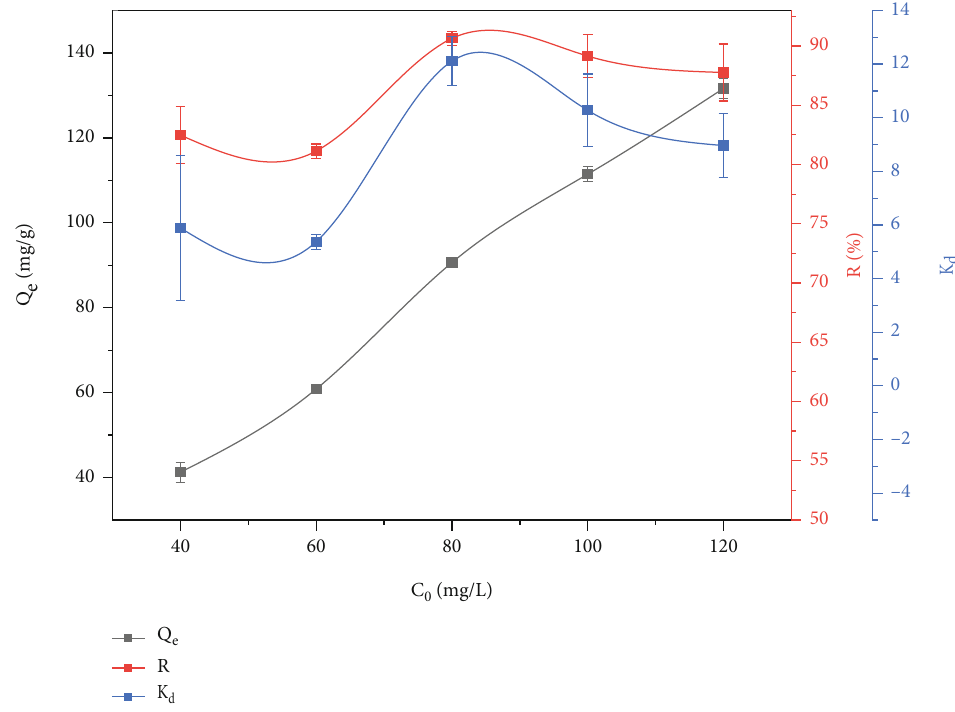
Figure 9: The e ff ect of GO concentration change on the adsorption of GO by red sandstone.